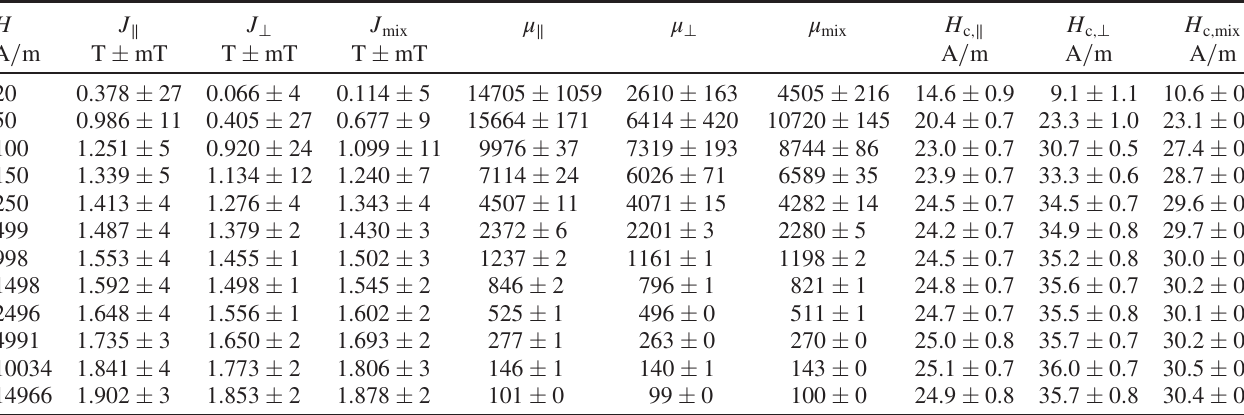
TABLE IV. Parameters of electrical